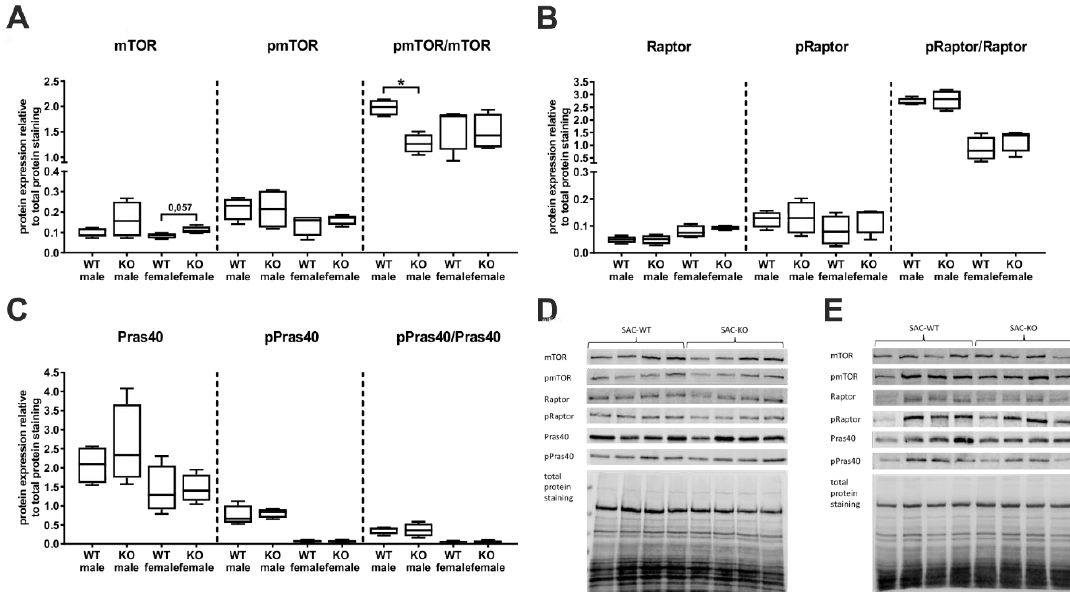
Figure 4. Western blot analysis of the impact of the hepatocyte-specific knockout of Hedgehog signalling on mechanistic target of rapamycin (mTOR) signalling. Densitometric analysis of the Western blots of ( A ): mTOR and its phosphorylation (p) at Ser2448. ( B ): Raptor and its phosphorylation (p) at Ser792. ( C ): Pras40 and its phosphorylation (p) at Thr246. ( D , E ): Representative example of the Western blots of male ( D ) and female ( E ) mice. * p ≤ 0.05; n = 4.